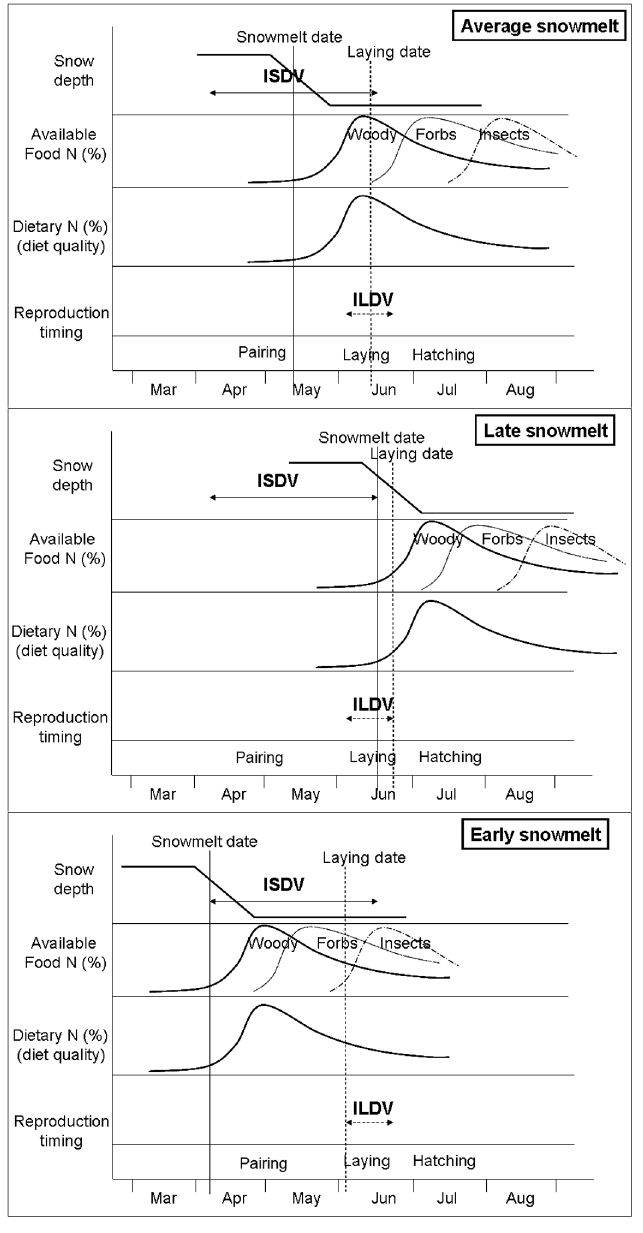
Fig 6. Explanatory model showing possible relationships between date of snowmelt, diet quality and reproductive success in Pyrenean ptarmigan. Average and both extremes of interannual snowmelt variation are shown. Snowmelt determines the beginning of growth and N content in the plants fed on by ptarmigan, which in turn regulates the N content of hen diets and protein increases during reproduction period. Previous data (Novoa et al. 2008) show that interannual variability of laying date (ILDV) are significantly less than interannual variability of snowmelt date (ISDV). Thus, in years of late snowmelt hens have less time to obtain good-quality food, resulting in poor body condition for laying and incubation, and diminishing breeding success. In years of early snowmelt, there is no loss of protein gain for ptarmigan hens, because of the asymmetric size of N content curve in plants and the appearance of new N peaks of major summer foods for ptarmigan (forbs and